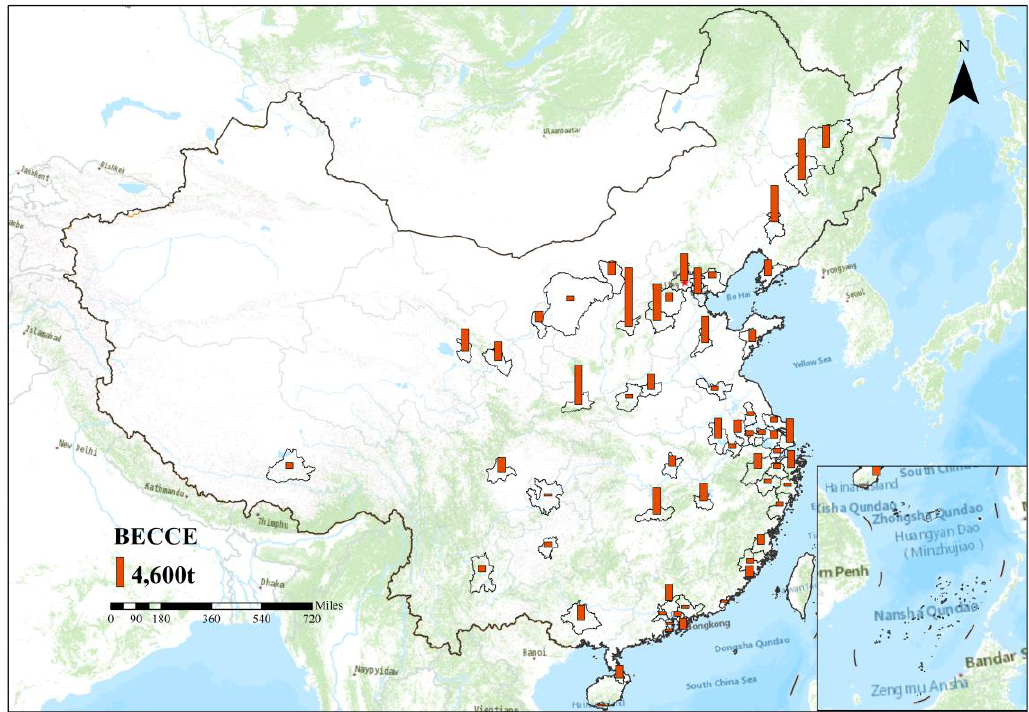
Figure 4. The building energy consumption carbon emission of the People ’ s Bank of China in the 59 selected cities. (Note: The unit of building energy consumption carbon emission is tons).